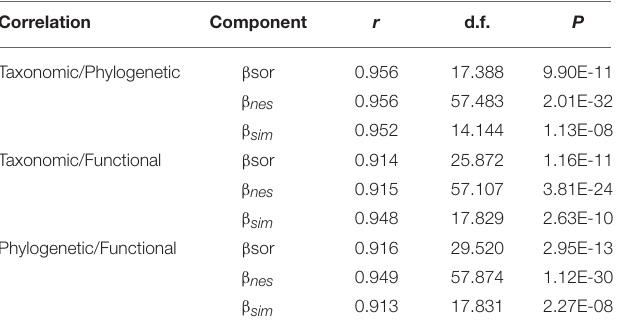
TABLE 1 | Spatial correlations for beta diversity and its components (turnover and nestedness) for the three dimensions of biodiversity (taxonomic, functional, and phylogenetic).